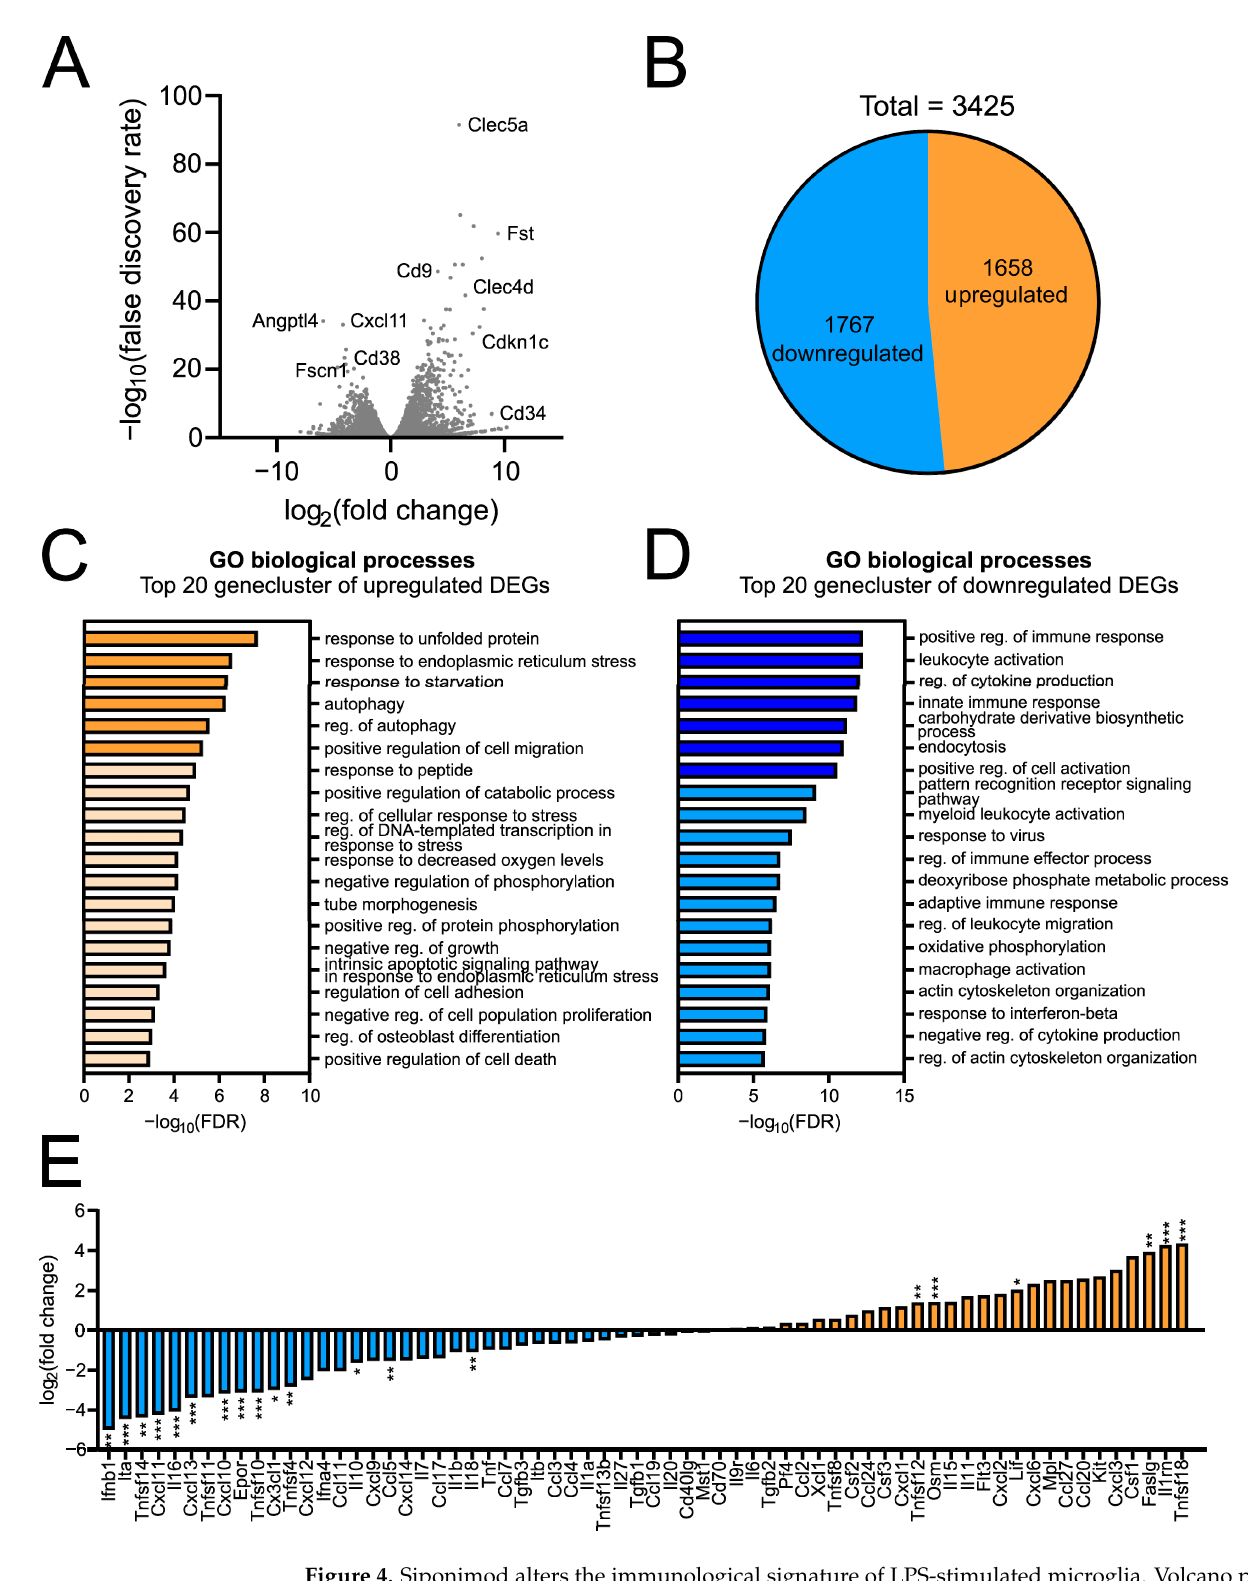
Figure 4. Siponimod alters the immunological signature of LPS-stimulated microglia. Volcano plots showing log 2 (fold-change) against log 10 (false discovery rate) for the comparisons of LPS/siponimod costimulated versus LPS-stimulated microglia ( A ). Identification of 3425 DEGs (fold change of ± 1.5 and an FDR adjusted p -value of ≤ 0.05), of which 1658 were up- and 1767 were downregulated ( B ). Gene Set Enrichment and Pathway analysis of up- ( C ) and downregulated ( D ) DEGs in order of